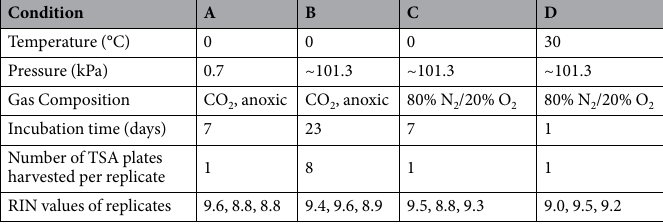
Table 1. Environmental conditions used in this